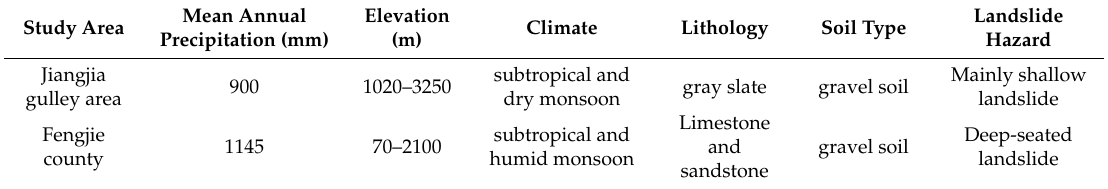
Table 1. The comparison of the Jiangjia Gulley area and the Fengjie county ([5,23,25]).